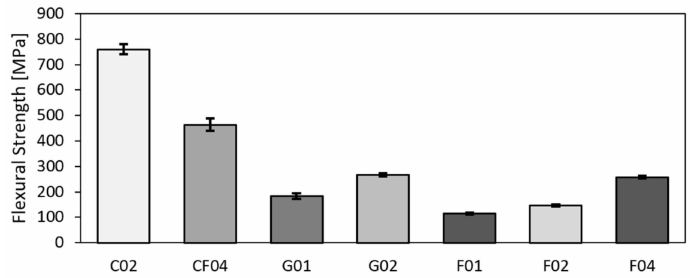
Figure 7. Flexural strengths of test